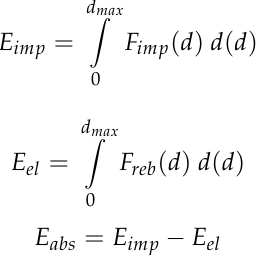
+/-Std.dev. +/-Std.err. Mean